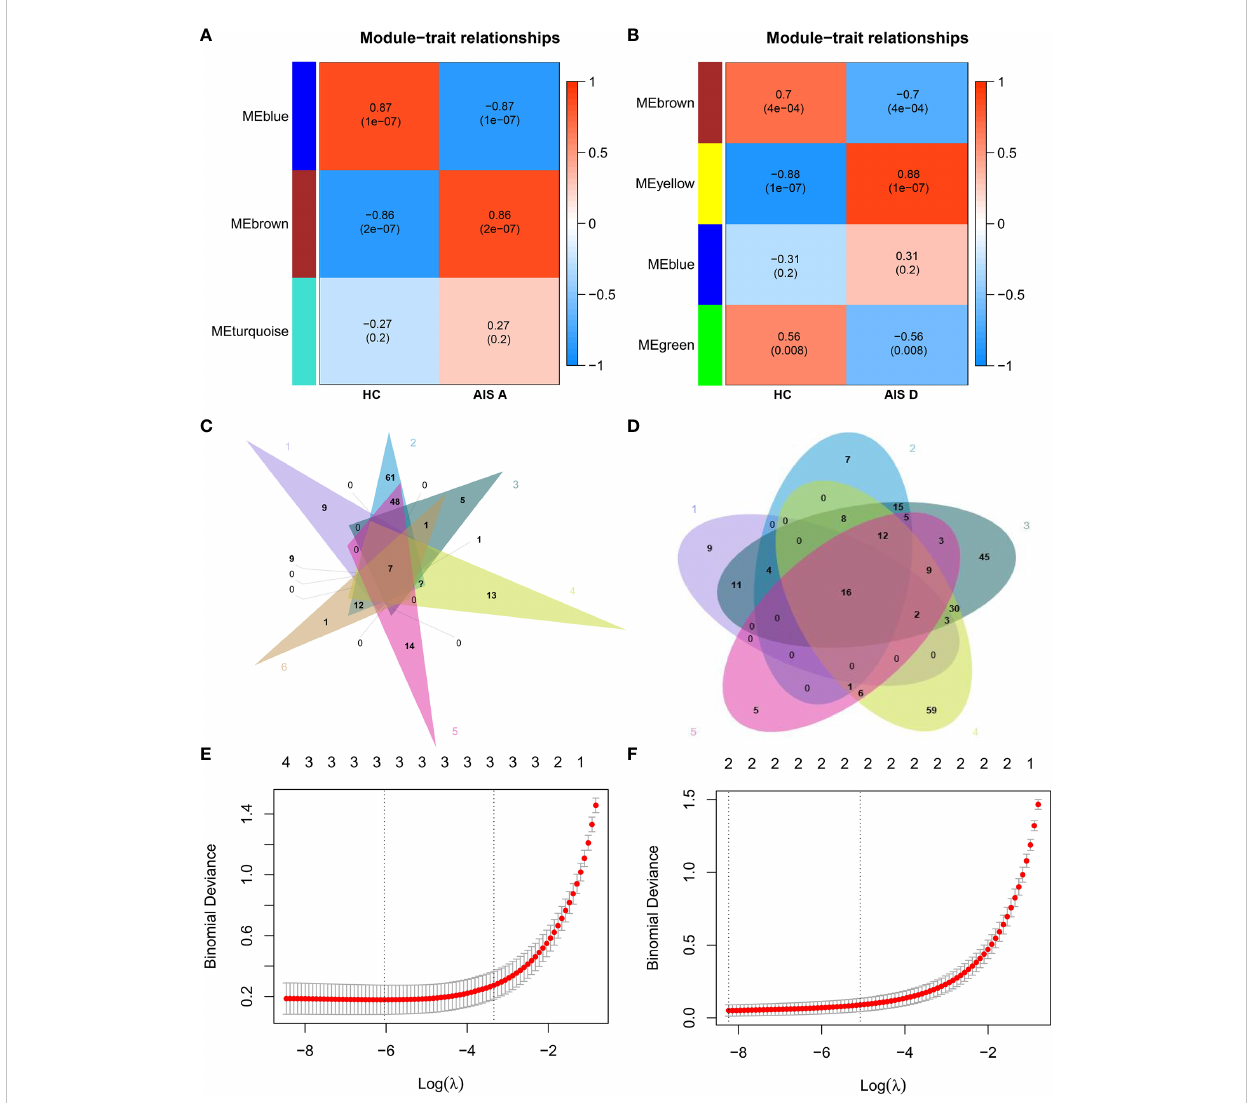
FIGURE 6 Identi fi cation of biomarkers of AIS A and AIS D grades of SCI. (A) Heatmap of correlations between module signature genes and clinical features of the AIS A grade of SCI. (B) Heatmap of correlations between module signature genes and clinical features of the AIS D grade of SCI. (C) Relatively speci fi c DEIGs of the AIS A grade of SCI were obtained based on a Venn diagram. (D) Relatively speci fi c DEIGs of the AIS D grade of SCI were obtained based on a Venn diagram. (E) LASSO logistic regression analysis of the AIS A grade of SCI. (F) LASSO regression analysis of the AIS D grade of SCI. SCI, spinal cord injury; HC, healthy uninjured control; AIS, American Spinal Cord Injury Association Impairment Scale; DEIGs, differentially expressed immune-related